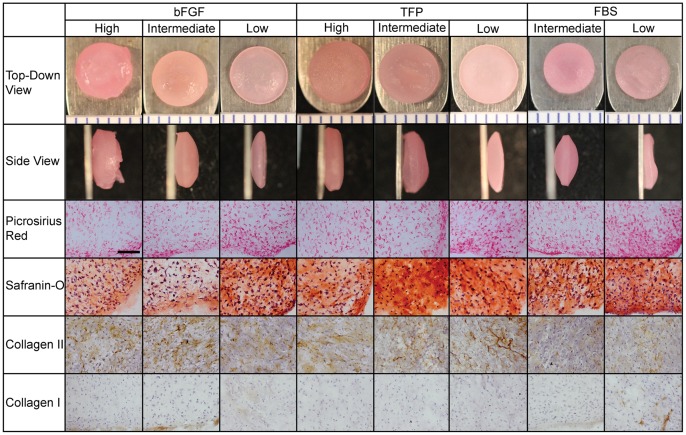
Construct Gross Morphology and Histology.Gross morphology and histology were imaged after 4 wks culture. All constructs stained positively for picrosirius red (collagen), Safranin-o (glycosaminoglycans), and type II collagen. More intense staining was apparent in Low density constructs. Type I collagen was detected in the periphery of constructs expanded with bFGF supplementation and minimally in constructs expanded in FBS-containing medium. Type I collagen was not detected in constructs expanded with TFP supplementation. Gross morphology ruler segments: 1 mm; histology scale bar: 100 µm.